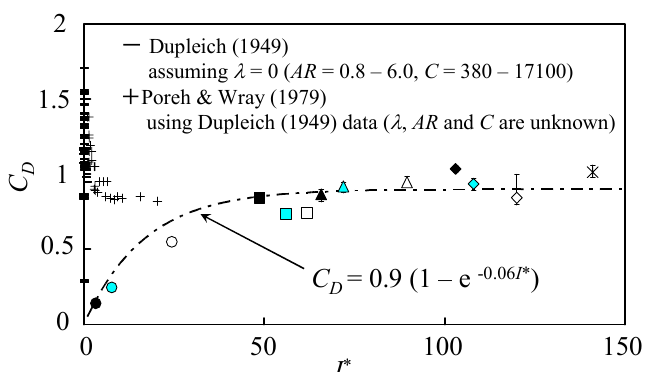
Fig. 13 Drag coefficient C D versus inertia-moment ratio I * , for several values of Reynolds number Re at